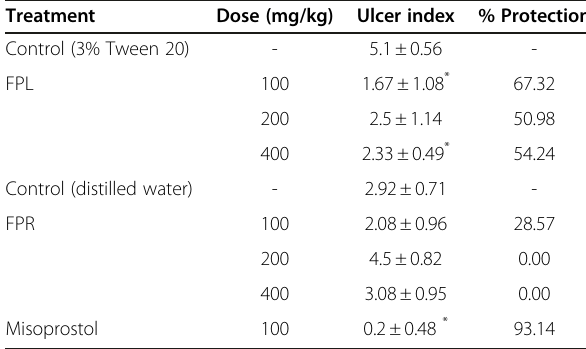
Table 2 Effect of F. paniculata leaf (FPL) and root (FPR) extracts on indomethacin induced gastric ulcer